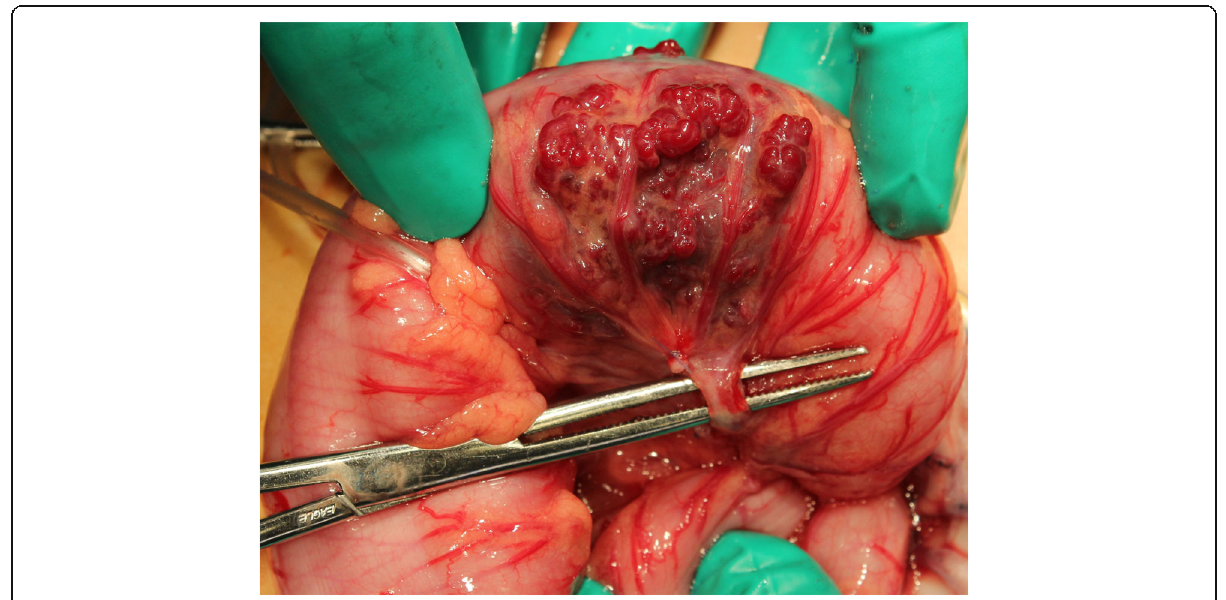
Fig. 2 Intraoperative photograph showing the vascular malformation on the serosal surface of the sigmoid